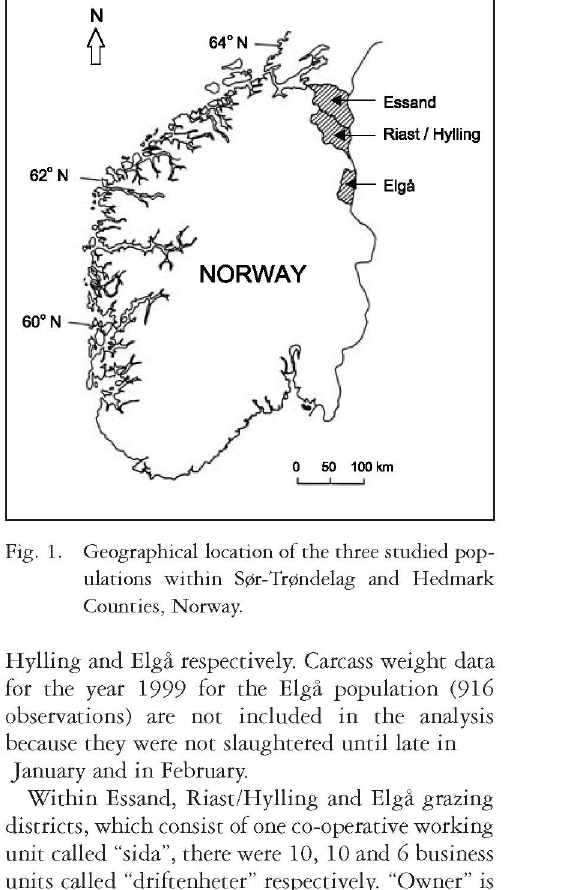
Fig. 1. Geographical location of the three studied pop ulations within S0r-Tr0ndelag and Hedmark Counties,